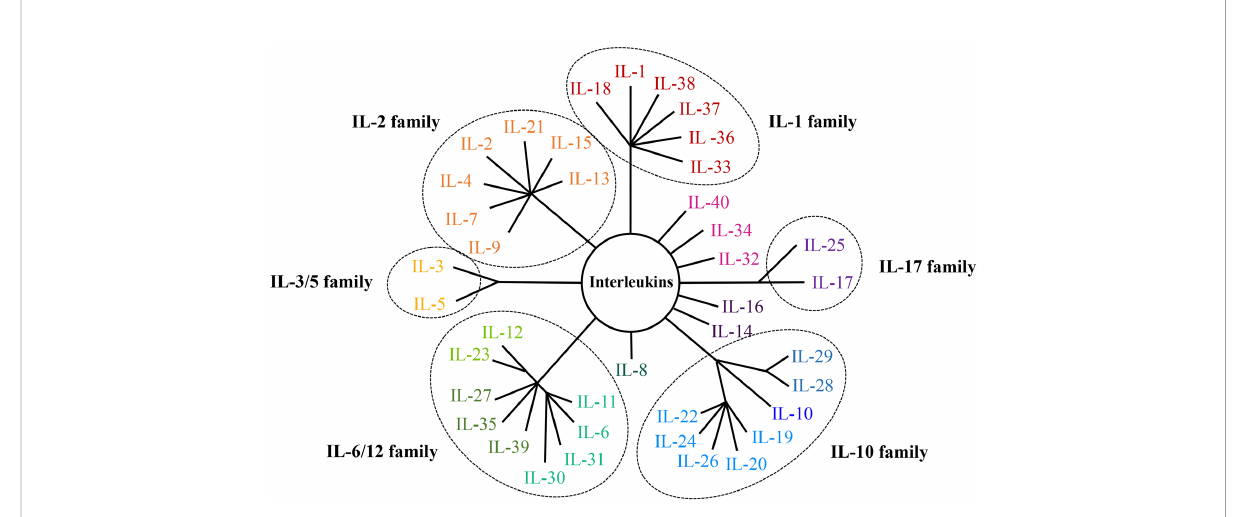
FIGURE 1 Classi fi cations and structures of the interleukin